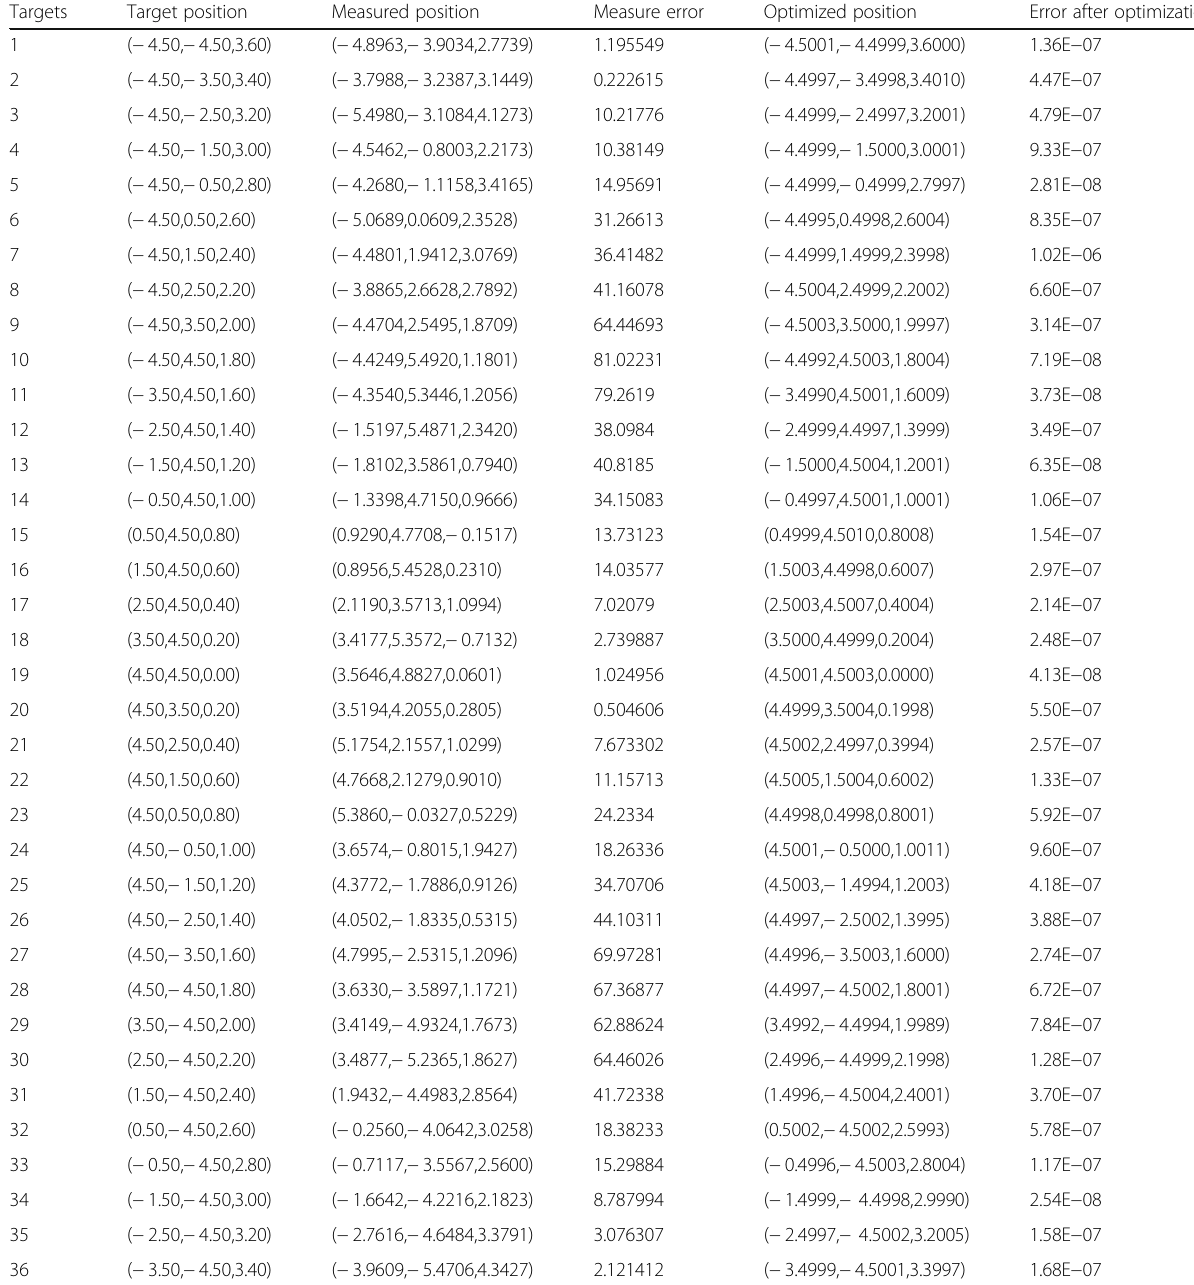
Table 5 Performance of 3D indoor localization using ELPSO